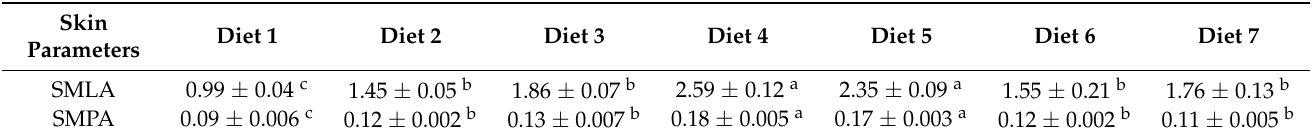
a,b,c—Different superscript letters indicate statistically different